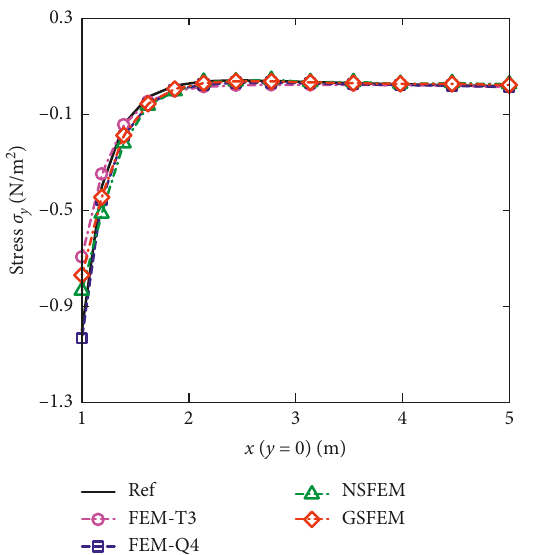
Figure 18: Stress along the bottom boundary ( y